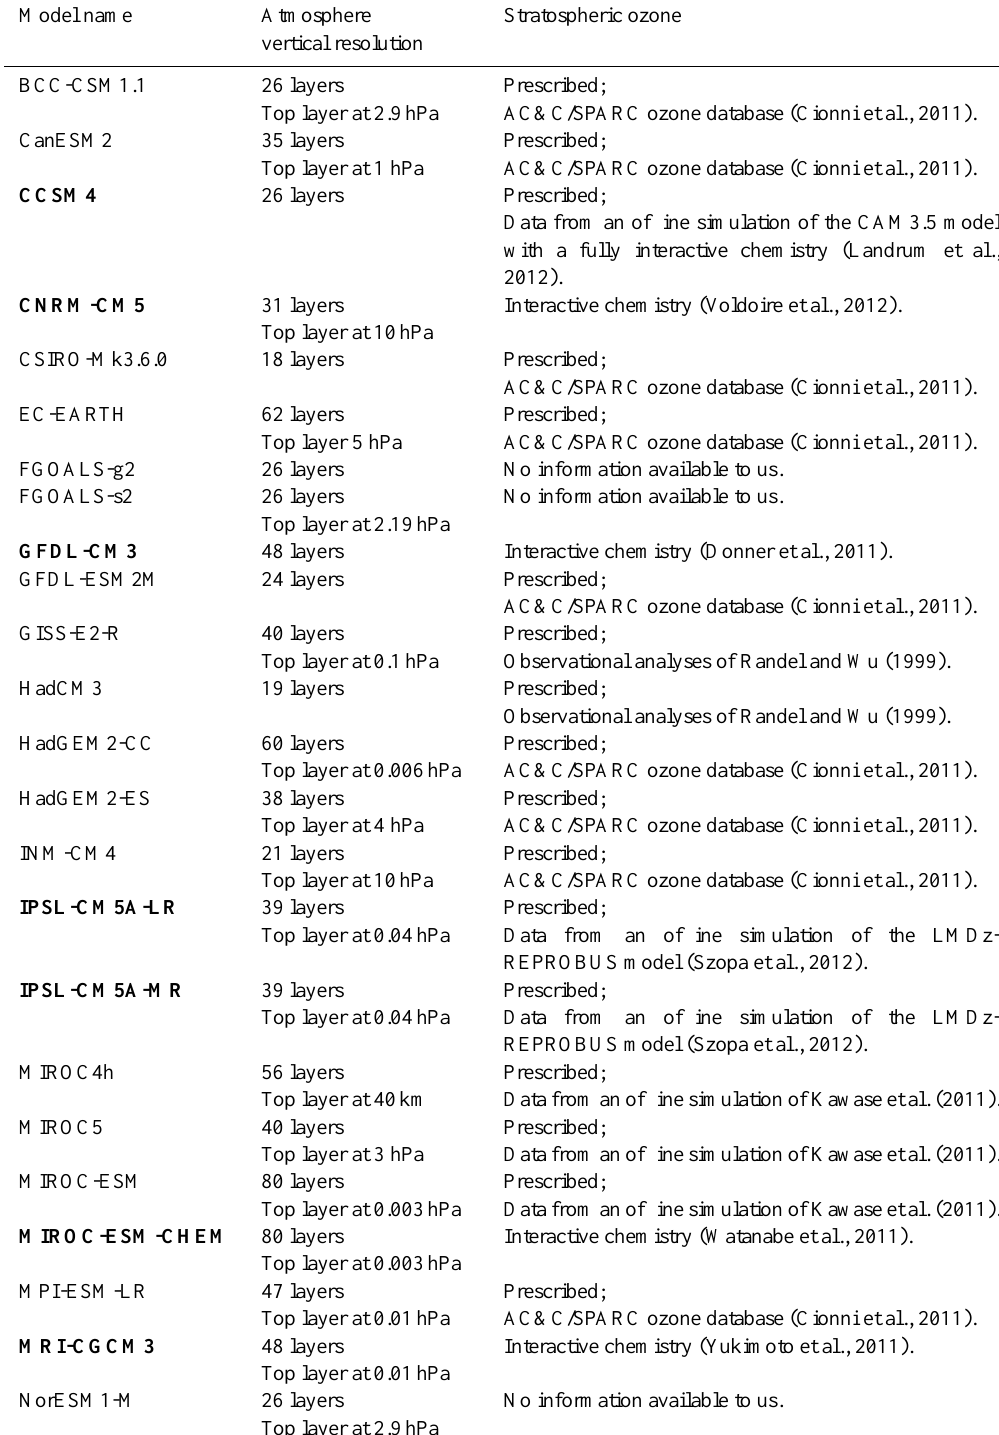
Table 2. Summary of atmosphere vertical resolution and stratospheric ozone representation. Models in bold are the ones with interactive chemistry, activated during the CMIP5 simulations or only activated in an offline simulation used to compute the ozone dataset prescribed in the CMIP5